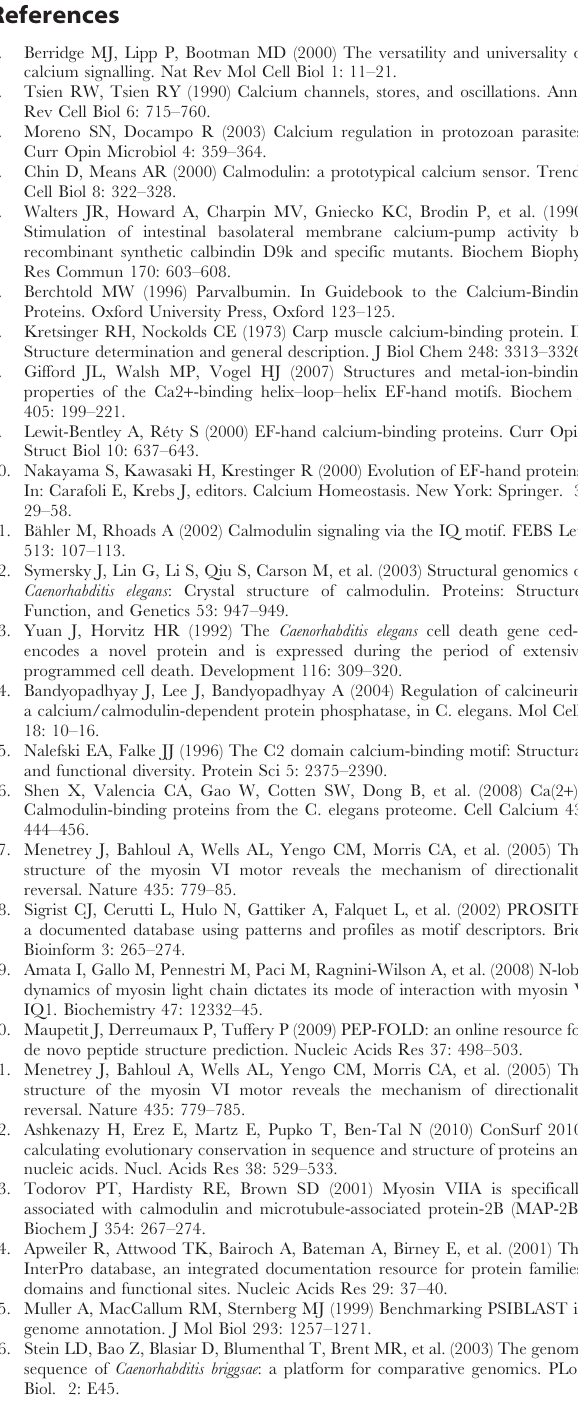
Table S3 Nearest homologue of EF-hand Proteins in organism other than Caenorhabditis genus. (PDF) Table S4 Calcium binding constant of EF-hand CaBP.